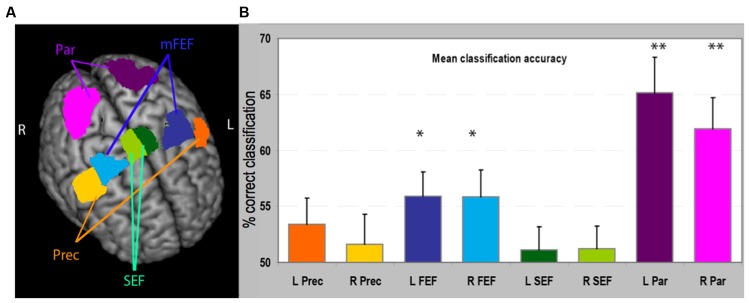
(A) Regions of interest (ROIs) used in the analysis reported on a 3D brain template. The stereotaxic coordinates and size of the regions are also reported in Table 1.
(B) Classification accuracy in the MVPA for these eight regions. For each region we have plotted the proportion of times the classifier, trained on independent data, correctly classified BOLD data as related to the execution of small or large saccades. Asterisks denote significantly higher proportion of correct classification than would be expected by chance, i.e., 50% (as determined by a permutation test). mFEF, frontal eye-field; Prec, inferior precentral cortex; Par, parietal cortex region; SEF, supplementary eye-field. ∗p < 0.05; ∗∗p < 0.001.